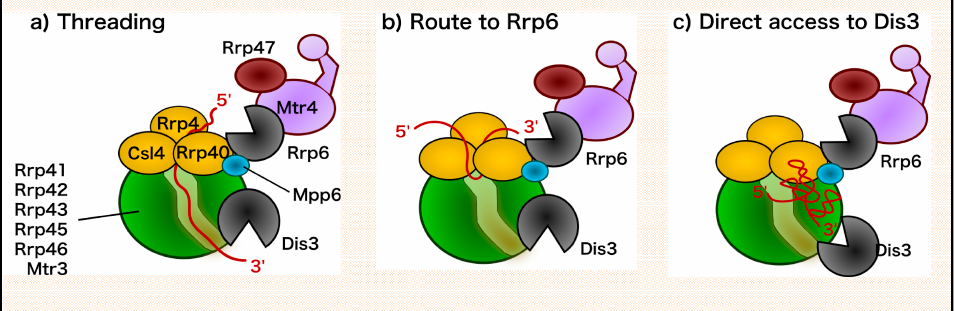
Figure 2. Structure of the RNA exosome and paths for RNA substrates to the catalytic subunits. ( a ) Threading route: RNA enters the central channel of the core exosome and reaches the active site of Dis3. ( b ) Route to Rrp6: RNA traverses the cap structure and reaches the active site of Rrp6. ( c ) Direct access to Dis3. RNA bypasses the central channel and directly accesses Dis3.